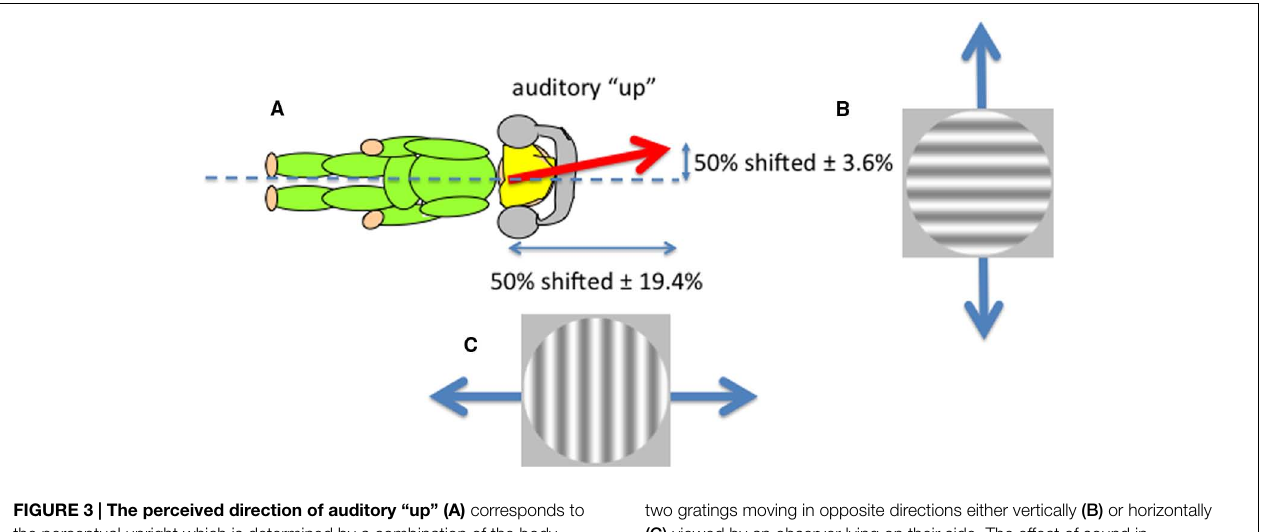
FIGURE 3 | The perceived direction of auditory “up” (A) corresponds to the perceptual upright which is determined by a combination of the body idiotropic vector and gravity with more emphasis on the body (Dyde et al., 2006). Non-spatial sounds differing only in their frequency content were used to disambiguate ambiguous visual motion created by superimposing